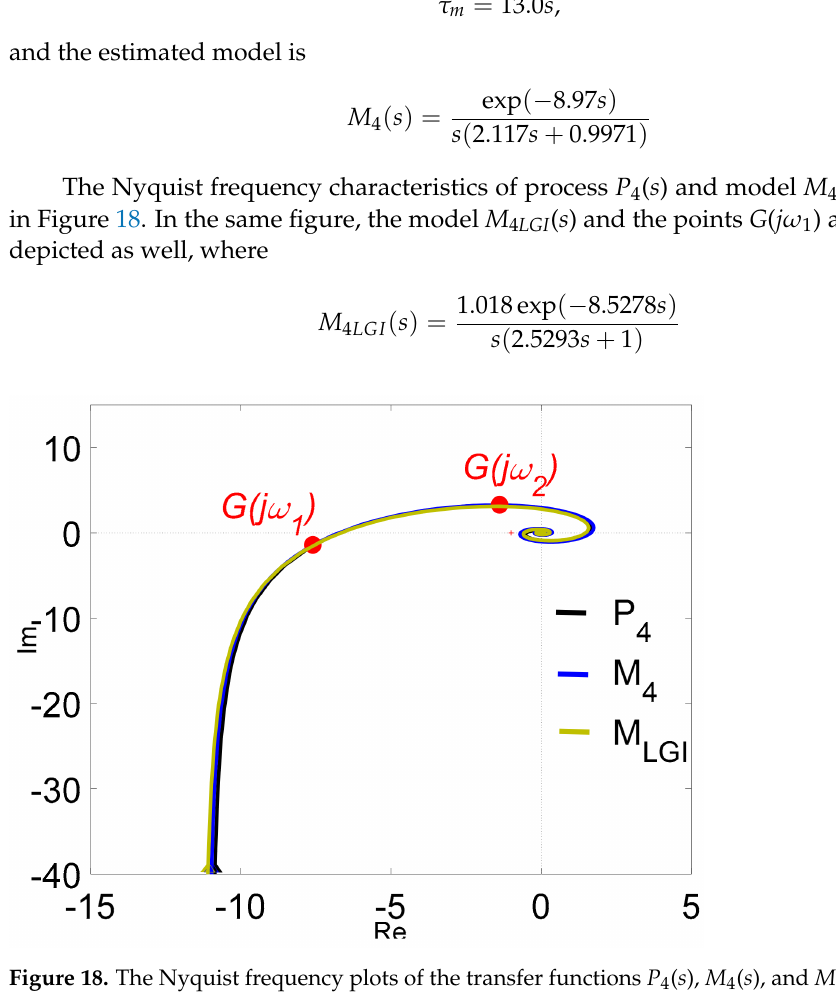
Figure 18. The Nyquist frequency plots of the transfer functions P 4 ( s ), M 4 ( s ), and M 4 LGI ( s